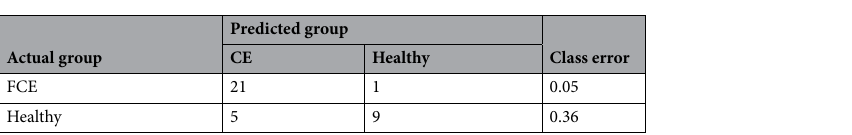
Figure 1. Multivariate analysis of the fecal metabolome of healthy cats and cats with chronic enteropathy. ( a ) Heat map showing metabolites that were significantly different between healthy cats and cats with inflammatory bowel disease (IBD) and alimentary small cell lymphoma (SCL). Groups are represented by the colored bars at the top of the figure as red (healthy, n = 14), green (IBD, n = 11), and blue (SCL, n = 11). Clusters can be identified between healthy cats and cats with chronic enteropathy (CE) but not between the disease subgroups IBD and SCL. ( b ) PCA score plots of metabolites in feces from healthy cats (green) and cats with chronic enteropathy (CE, red). ( c ) PCA score plots of metabolites in feces from healthy cats (red), cats with inflammatory bowel disease (blue), and cats with alimentary small cell lymphoma (green). A cluster can be identified for healthy cats but no specific clusters can be seen for the subgroups of IBD and SCL. Data was mean centered and divided by the standard deviation of each variable (autoscaled).